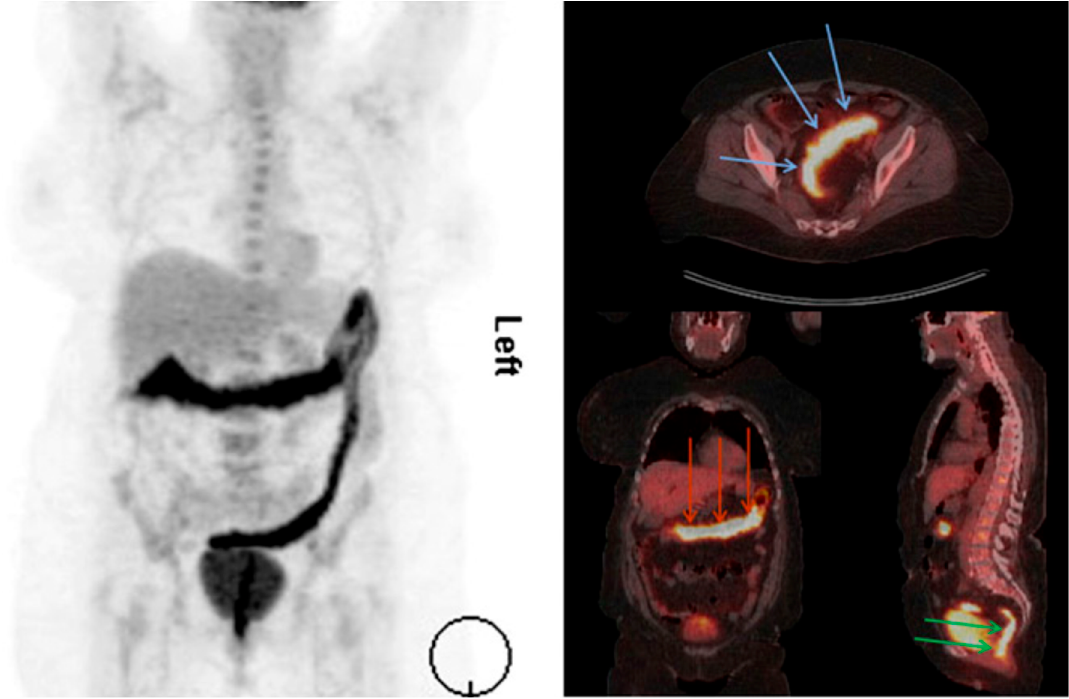
Figure 3. 18 F-FDG PET / CT scan of ulcerative colitis (UC) patient. Extent of disease is seen on the left and in areas indicated by arrows in the right panel [124].